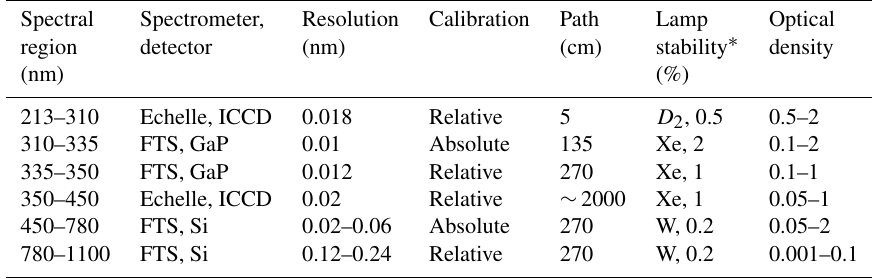
Table 4. Experimental details and statistical uncertainty of OD spectra for different wavelength regions for SG data (Serdyuchenko et al., 2014). FTS denotes the Fourier transform spectrometer. The detector types used are silicon (Si) and germanium phosphorus (GaP) photodiodes, as well as an intensified charge-coupled device